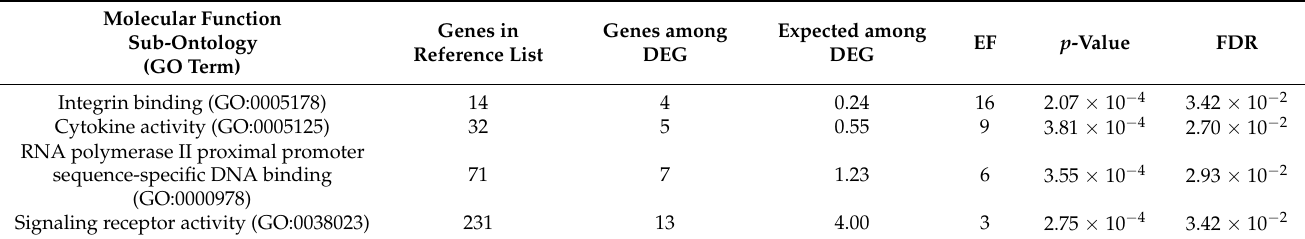
Table 5. The slim molecular function ontology terms overrepresented in the differentially expressed genes in the T98G human glioblastoma exposed for 72 h to 20 µ g/mL of TiO 2 -NPs. Only the results for FDR p < 0.05 are displayed. Molecular Function Sub-Ontology